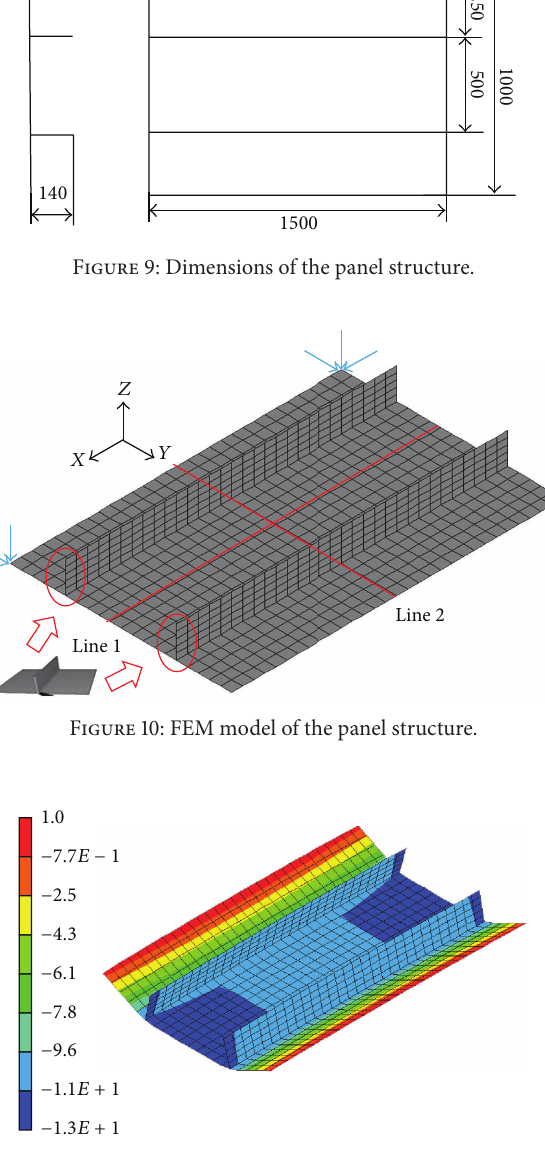
Figure 11: 𝑍 -displacement distribution.